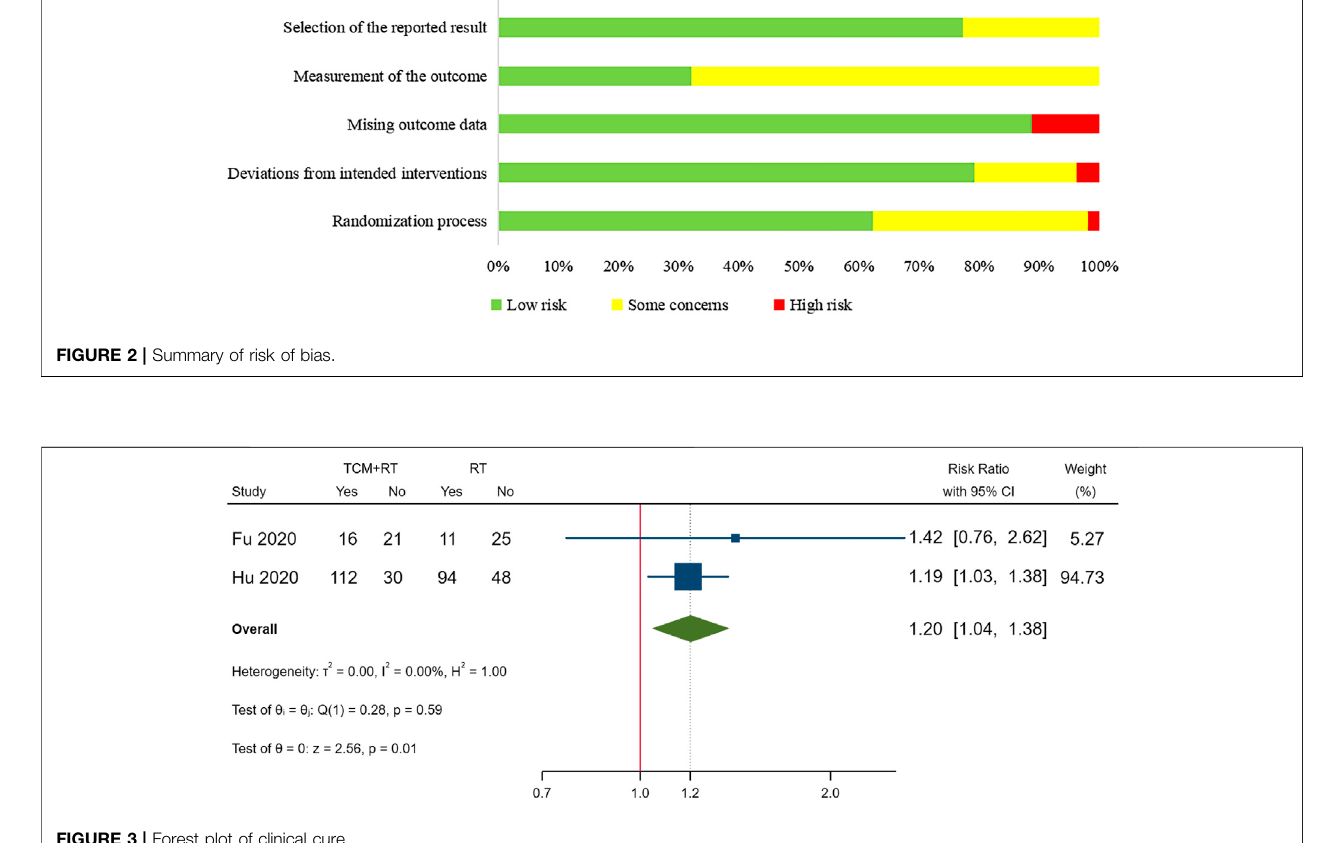
FIGURE 3 | Forest plot of clinical cure.